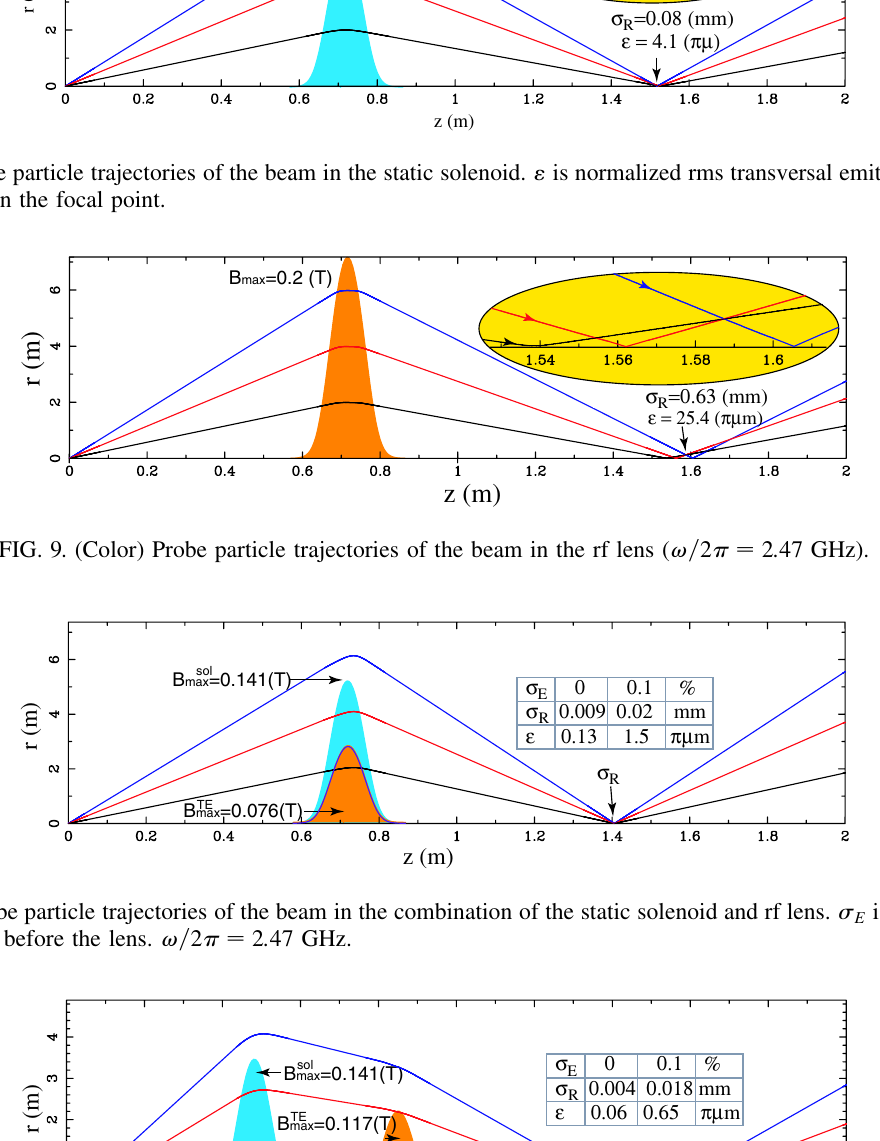
FIG. 11. (Color) Probe particle trajectories of the beam in the combination of the static solenoid and rf lens ( != 2 (cid:5) (cid:4) 2 : 47 GHz ).